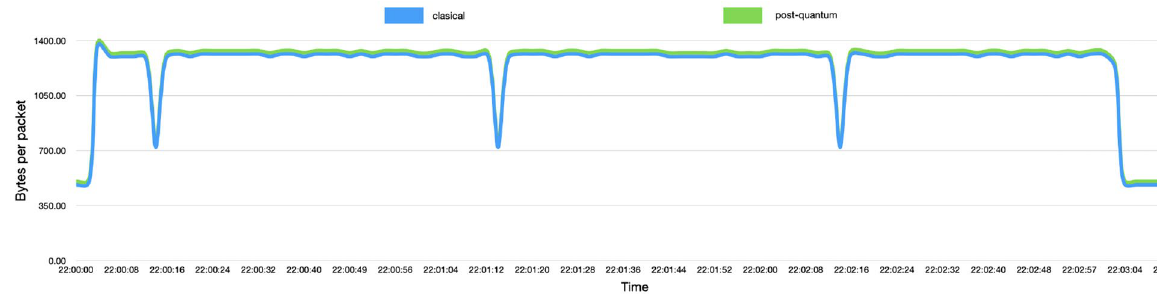
Figure 6. Bytes per